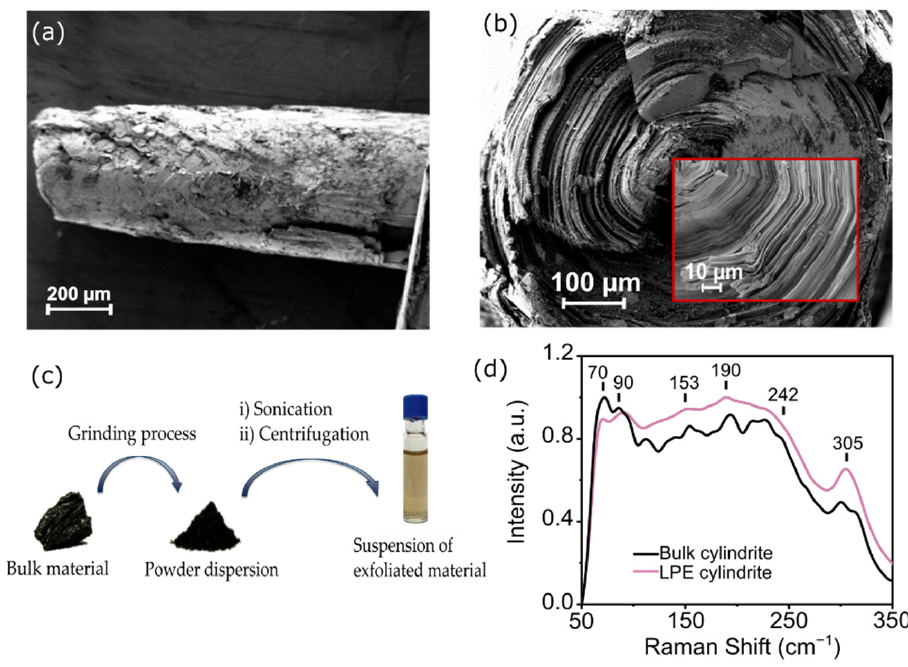
Figure 1. ( a ) Scanning Electron Microscopy (SEM) image of an individual cylindrite cylinder and ( b ) its transverse-plane. The inset shows an amplified region around the revolution axis of the cylinder. ( c ) Schematic of the two-step Liquid Phase Exfoliation (LPE) process. Starting from the bulk mineral, some cylinders are extracted and ground in an agate mortar until a black powder is obtained. The powder is dispersed in i PrOH at a 1 mg · mL − 1 concentration and is sonicated in an ultrasonic bath and centrifuged in order to eliminate not-exfoliated flakes. ( d ) Normalized Raman spectra ( λ exc = 532 nm) of cylindrite bulk (black line) and LPE cylindrite obtained after sonication of a 1 mg · mL − 1 powder dispersion in i PrOH (purple line).